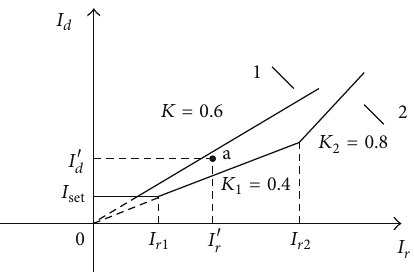
Figure 3: The characteristic curves of segregated phase current differential